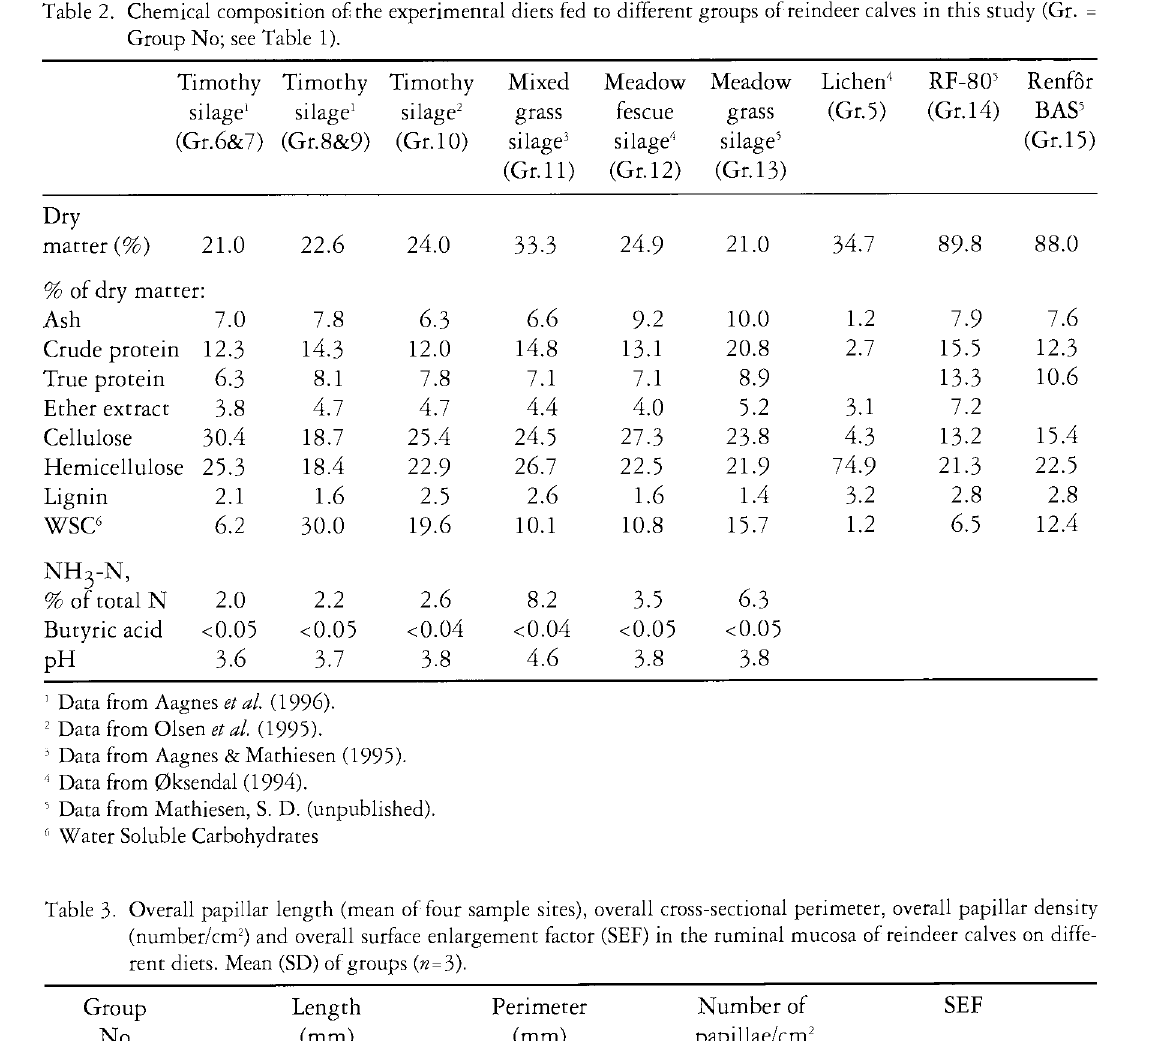
Table 3. Overall papillar length (mean of four sample sites), overall cross-sectional perimetet, overall papillar density (number/cm 2 ) and overall surface enlargement factor (SEF) in the ruminal mucosa of reindeer calves on diffe rent diets. Mean (SD) of groups (» =